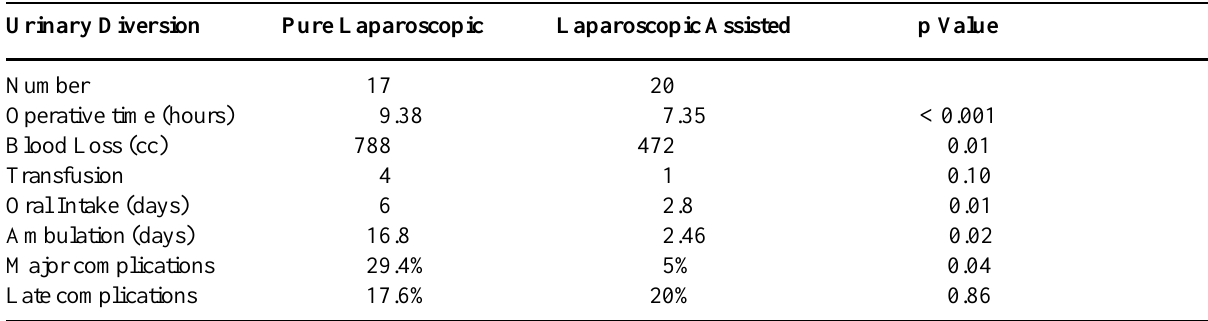
Table 4 – Laparoscopic radical cystectomy with urinary diversion. Pure laparoscopic vs. laparoscopic assisted.